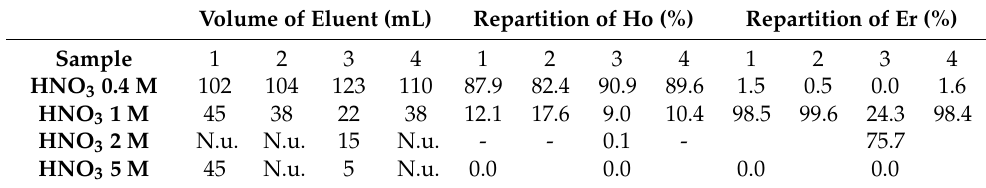
Table 2. Elution of 4 samples on semi-automated system separation of Er/Ho. Volume of Eluent